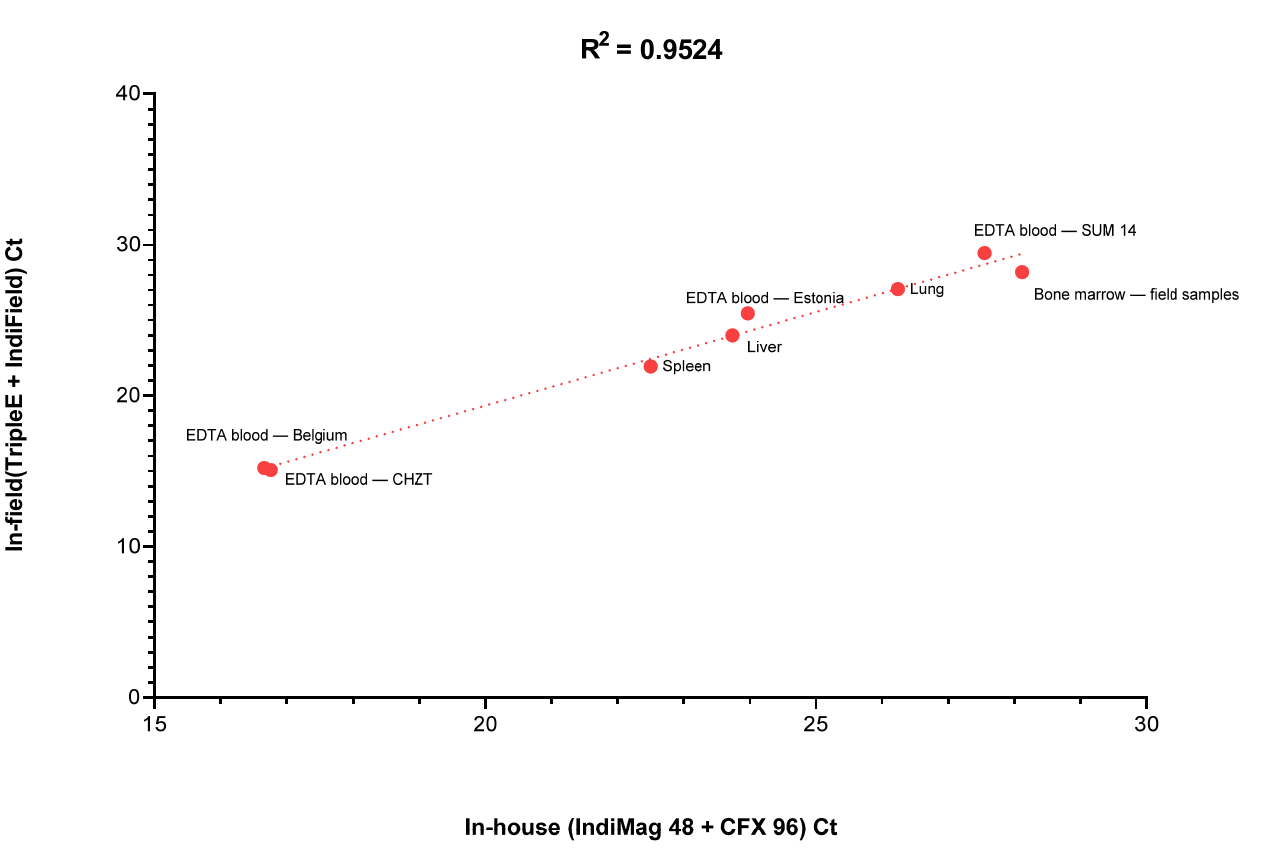
Figure 3. Comparison of the mean Ct values obtained from the same samples tested on the portable in-field system (Triple E + IndiField PCR system) versus the standard laboratory-based system (IndiMag 48 + CFX 96 PCR system). A Spearman correlation coefficient test was performed using GraphPad Prism 8 (GraphPad Software Inc., San Diego, CA, USA).